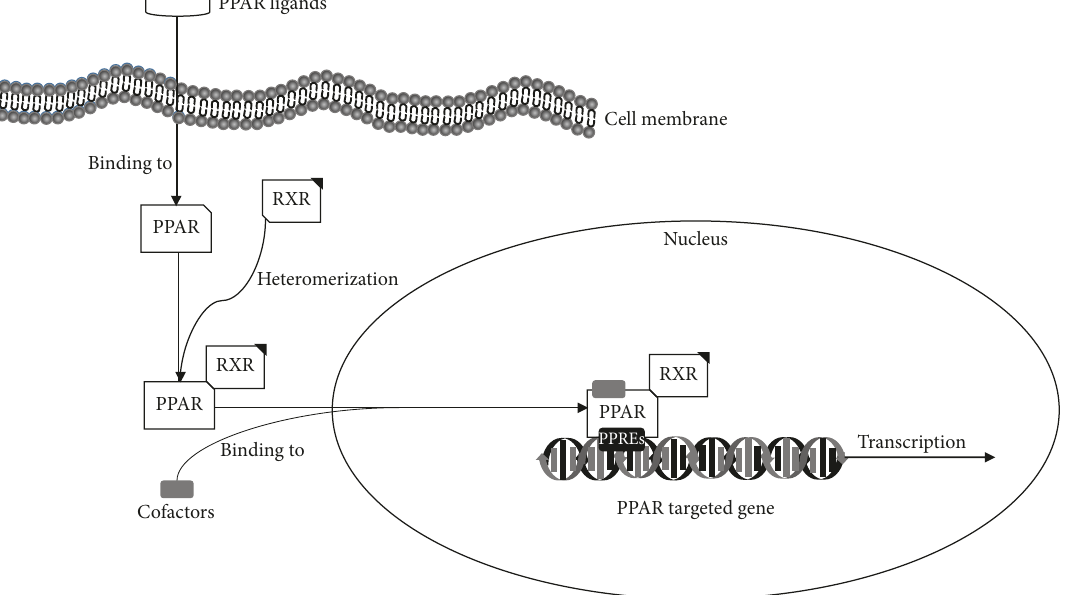
Figure 3: Activation of PPAR-RXR complex, leading to PPAR-targeted genes